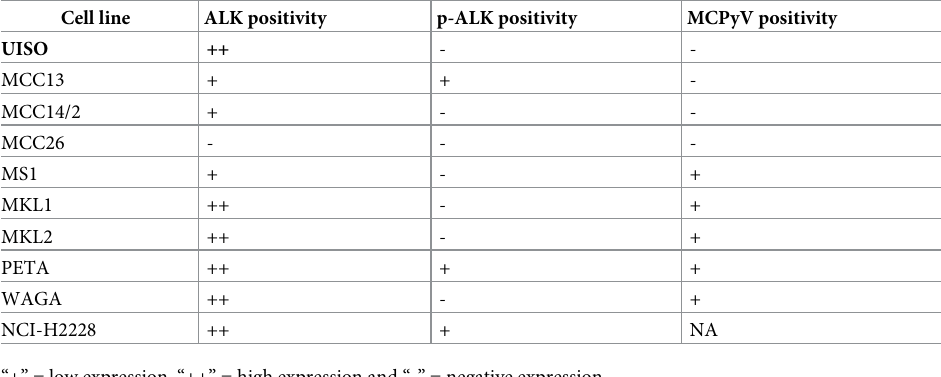
“+” = low expression, “++” = high expression and “-” = negative